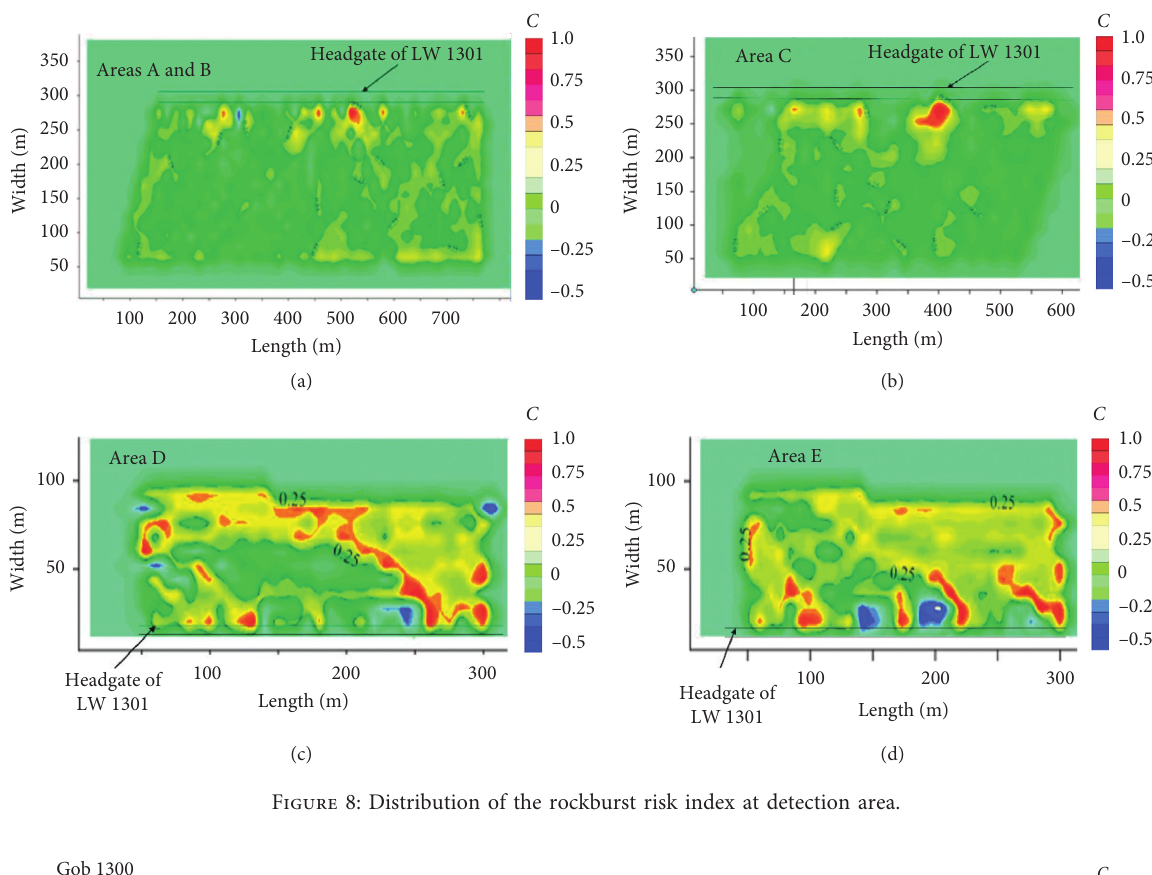
Figure 8: Distribution of the rockburst risk index at detection area.